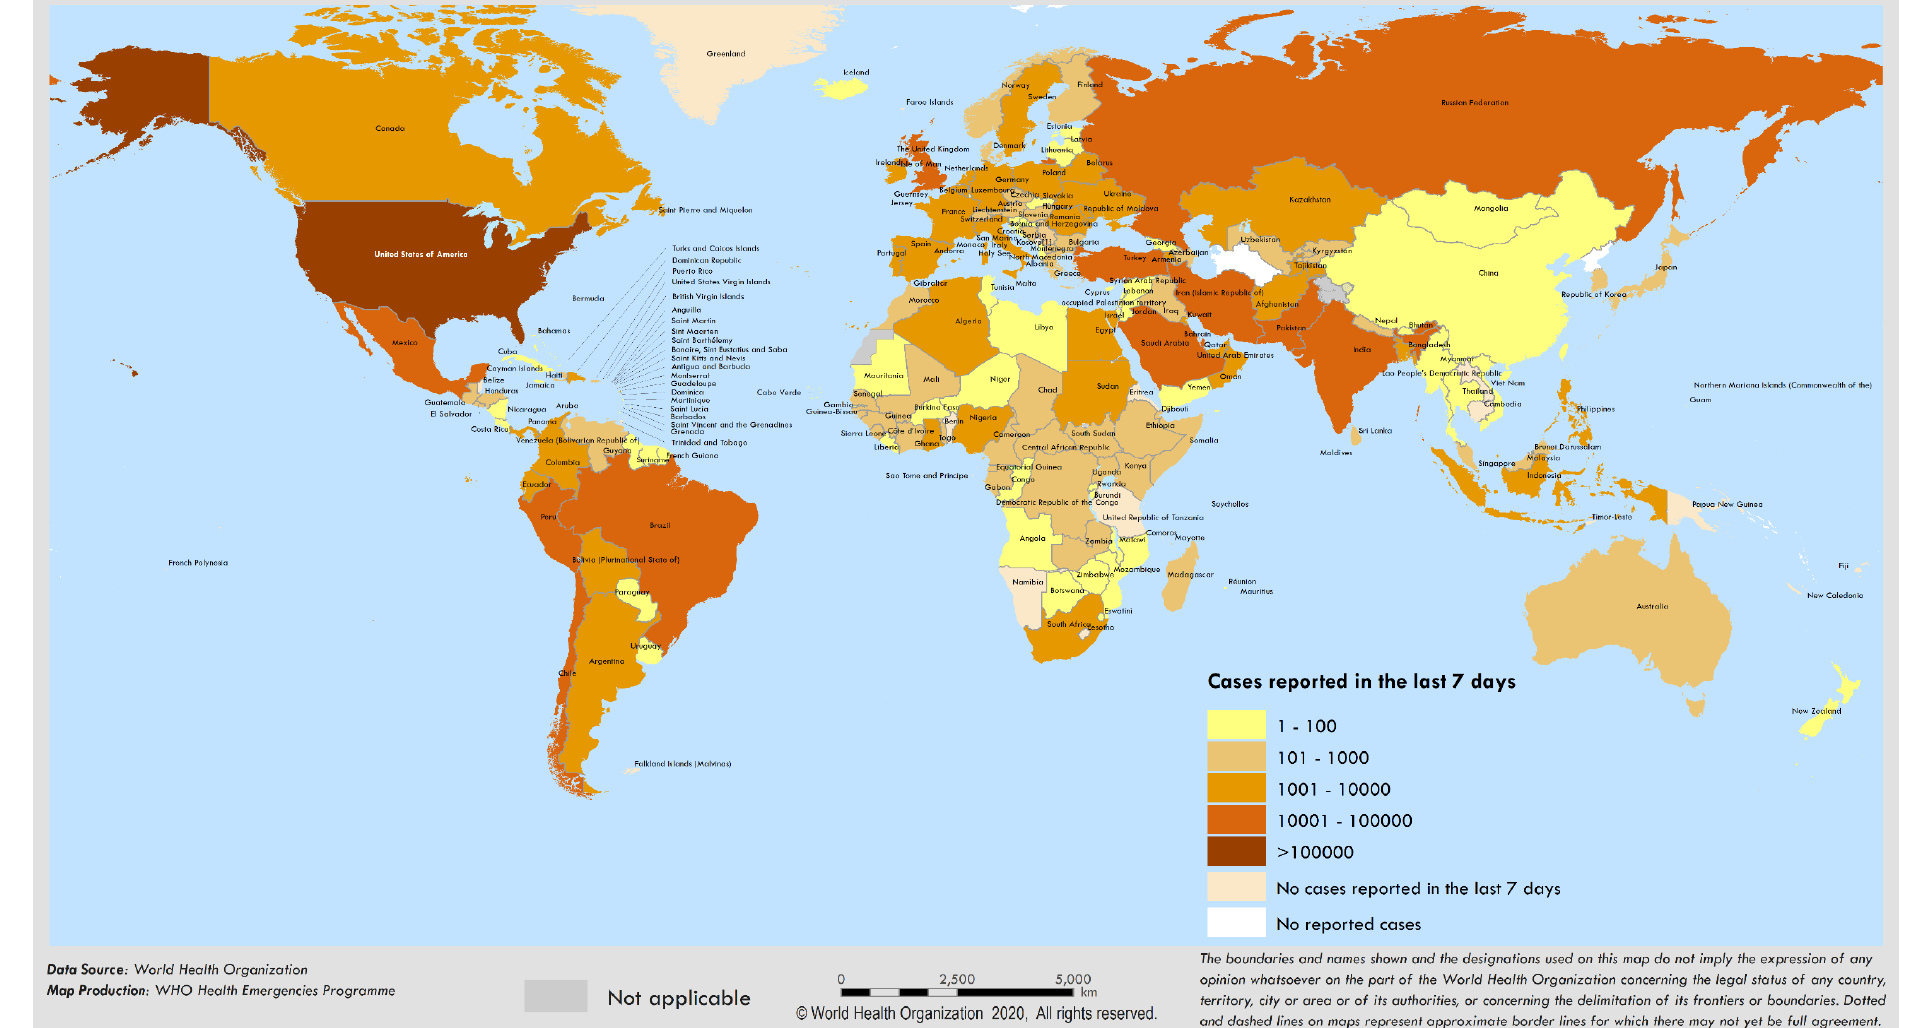
**See Annex 1 for data, table and figure